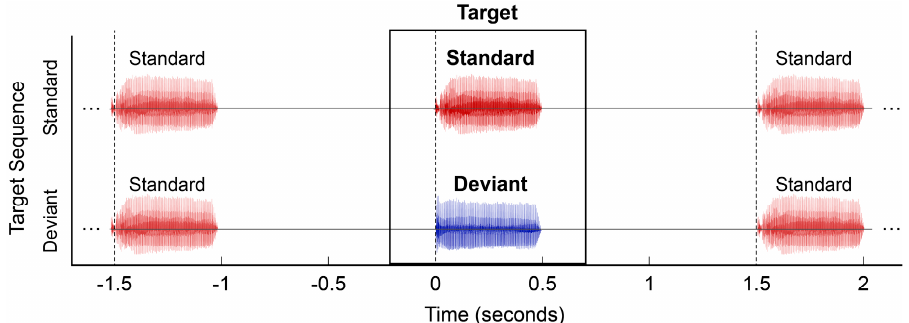
Figure 1. Schematic illustration of the stimulus sequences used for testing. Each waveform represents the presentation of either a “Standard” sound (/ba/or/PT/) shown in red or of a “Deviant” sound (/da/or/BBN/) shown in blue. The abscissa represents time (in seconds) relative to the onset of an identi fi ed target stimulus in the presentation sequence.